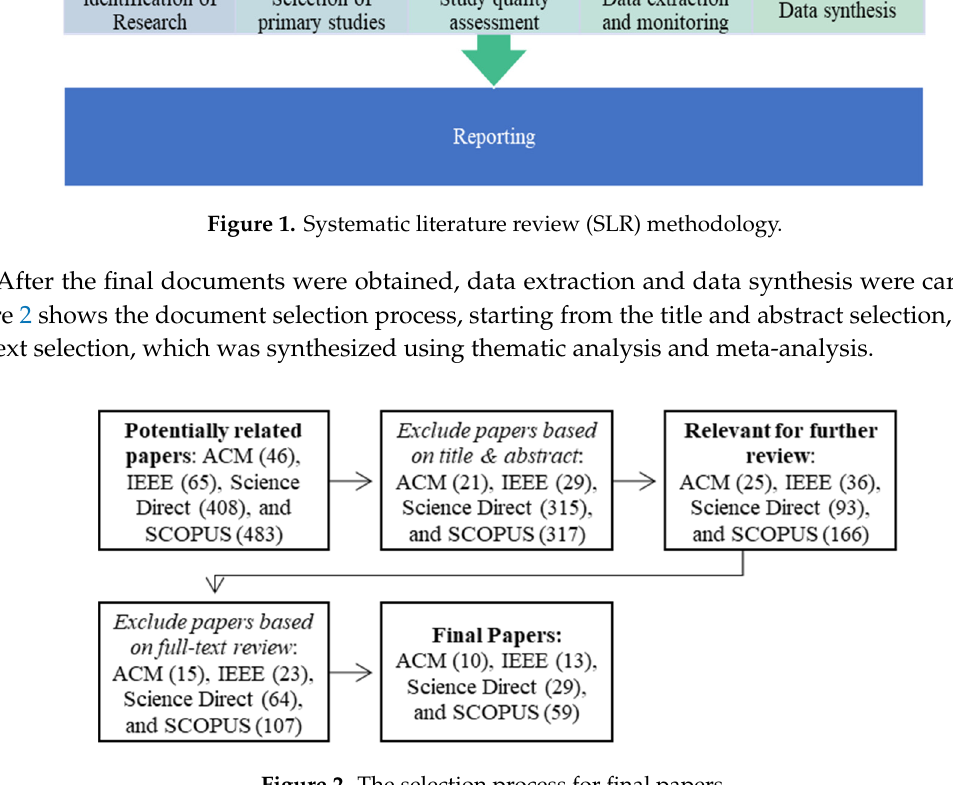
Figure 2. The selection process for final papers.